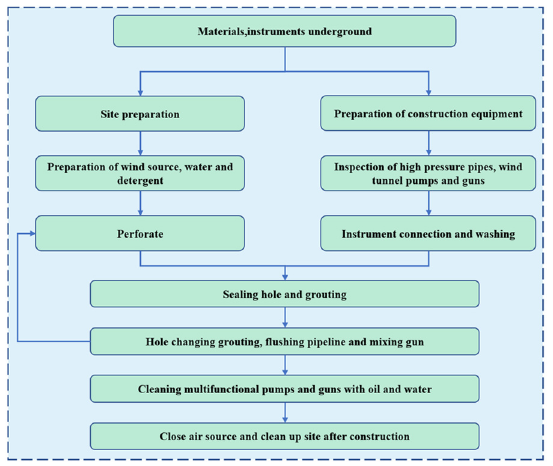
Figure 6. Grouting process flowchart.